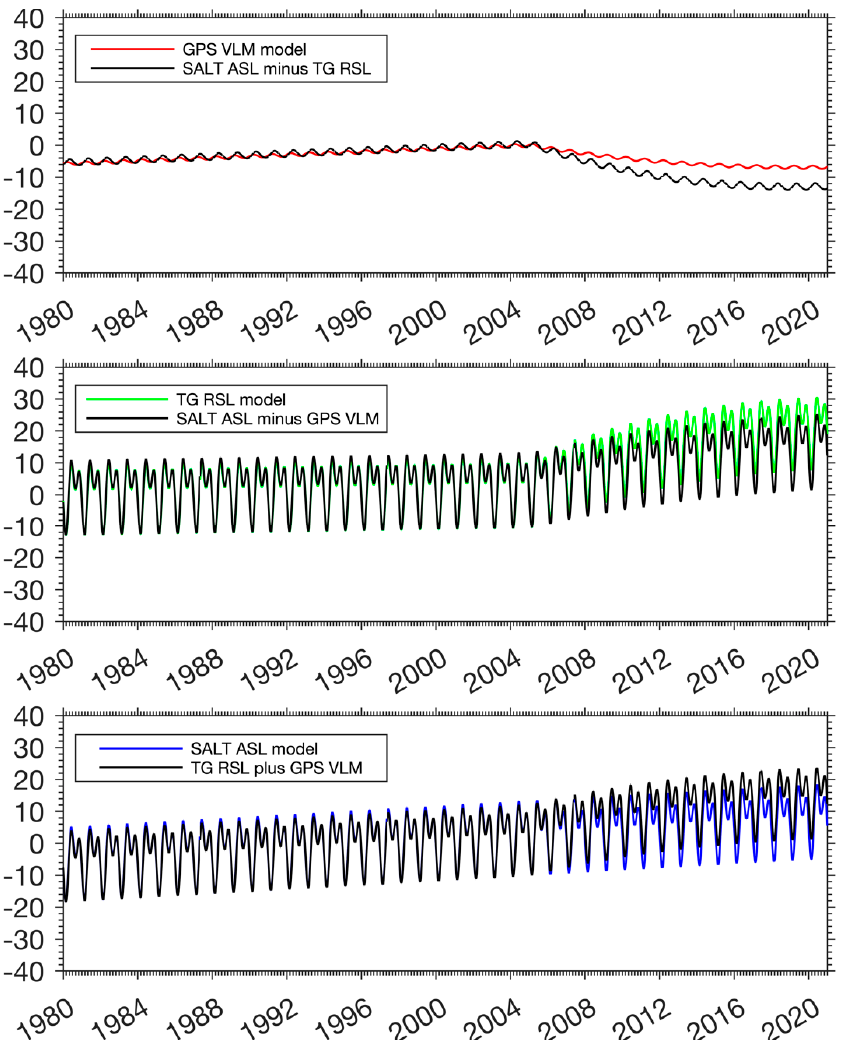
Figure 7. Top to bottom, the model fits for GPS (VLM), TG (RSL) and SALT (ASL) data at KTN tide-gauge station. They have been plotted in red, green, and blue, respectively. The black lines follow from the synthesized result for VLM (SALT-TG), RSL (SALT-GPS) and ASL (TG plus GPS). It shows the perfect fit up to the time of the Mw 9.2 earthquake (26/12/2004) and a similar but slightly growing deviation after. The vertical axis unit is cm, and the horizontal axis is time in years. Table 3. Summary of the model fits through the SALT, TG and GNSS data. First column gives the trend in mm/yr before 2005, the 2nd column the annual cycle (amplitude in cm and phase in days after 1 January), the 3rd column the semi-annual cycle (again amplitude and phase), 4th column the amplitude of the exponential decay after 2005 in cm and the 5th column the residual RMS after the fit (in cm).